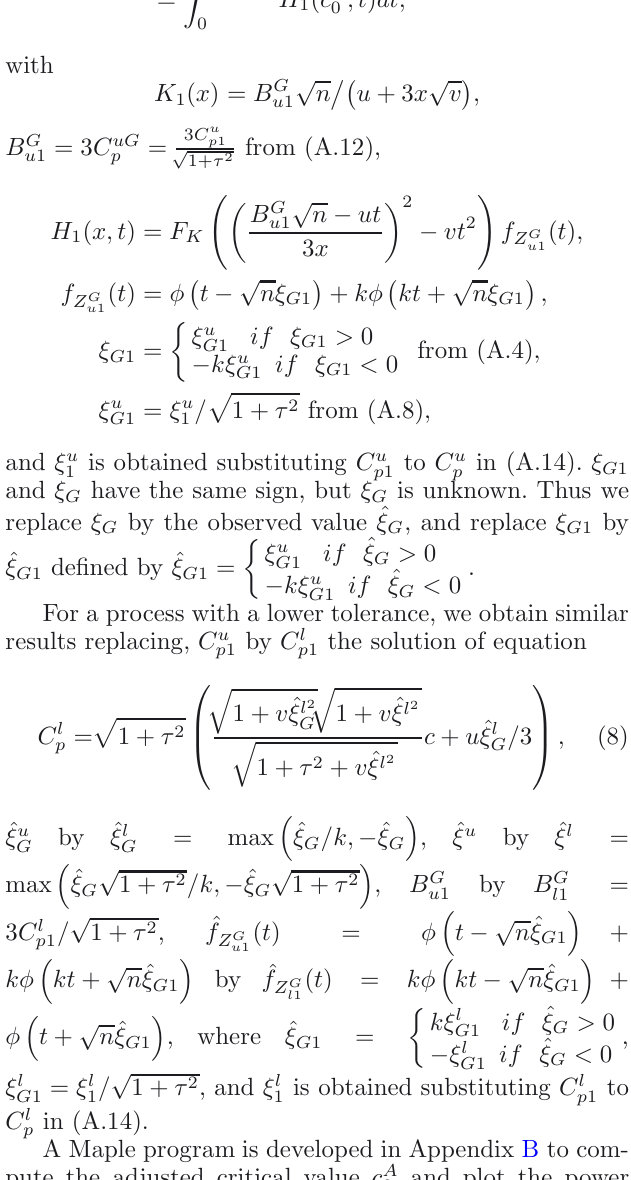
test. Figure 3 plots π A versus τ ∈ [0 , 1] with u = 0 . 5, v = 1 . 5, k = 3, n = 50, α = 0 . 05, c = 1 . 00 , 1 .